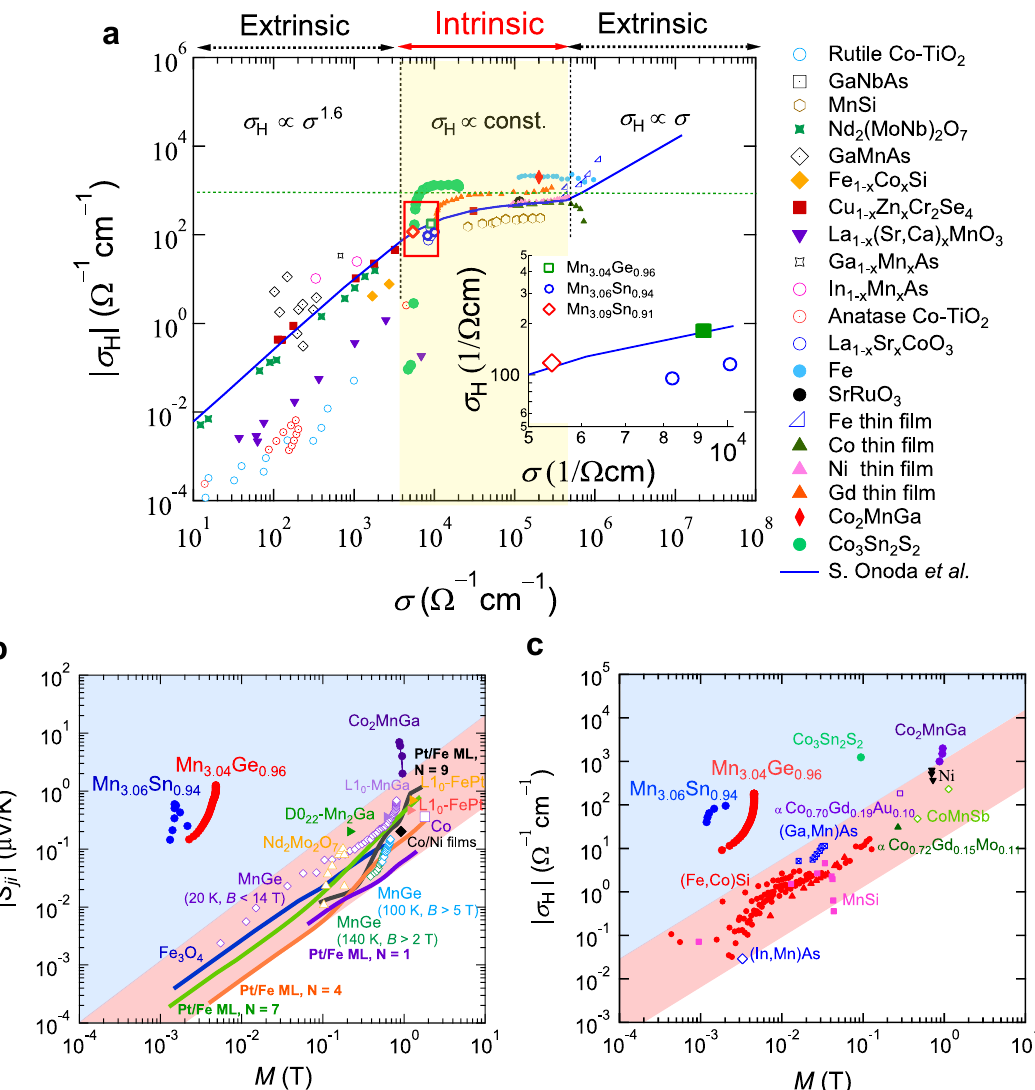
Fig. 6 Universal scaling relations for the magnetic Weyl semimetals. a Universal scaling relation between the Hall conductivity, σ H , and the longitudinal conductivity, σ , for Mn 3.04 Ge 0.96 (2 and 10K), Mn 3.06 Sn 0.94 (60 and 100K), and Mn 3.09 Sn 0.91 (100K) 4,9 , plotted together with the data for various ferromagnets including transition metals (Ni, Gd, Fe, and Co thin fi lms) 87 , Fe single crystals 87 , Co 3 Sn 2 S 2 31 , MnSi 89 , Fe 1- x Co x Si 89 , perovskite oxides (SrRuO 3 , La 1- x Sr x CoO 3 , La 1- x (SrCa) x MnO 3 ) 71 , spinels (Cu 1- x Zn x Cr 2 Se 4 ) 71 , pyrochlore (Nd 2 (MoNb) 2 O 7 ) 71 , and magnetic semiconductor (Ga 1- x Mn x As, In 1- x Mn x As, anatase – Co – TiO 2 , rutile – Co – TiO 2 ) 71 . Within the good metal regime of 3 ´ 10 3 (cid:3) σ (cid:3) 5 ´ 10 5 Ω (cid:2) 1 cm (cid:2) 1 (yellow shaded area), σ H is predominated by the intrinsic Berry phase contribution. The value of σ H lies below about 10 3 Ω − 1 cm − 1 (horizontal dotted line) and is nearly constant with σ . In the regime of σ (cid:4) 5 ´ 10 5 Ω (cid:2) 1 cm (cid:2) 1 , the extrinsic skew scattering contribution dominates σ H . The solid line presents the theoretical prediction by ref. 88 . Inset: zoomed plot showing the data for the Mn 3 Sn and Mn 3 Ge single crystals with different compositions, which corresponds to the region framed by the red rectangle in the main panel. b , c Full logarithmic plot of the magnetization ( M ) dependence of the Nernst coef fi cient j S ji j ( b ) and the Hall conductivity σ H ( c ) for Mn 3 Sn (blue), Mn 3 Ge (red), and other Weyl magnets 4,9,21,31 , in comparison with those for ordinary ferromagnets 9,26,71,87,96 . The red shades mark the regions in which j S ji j or σ H is linearly related to M for conventional ferromagnets. The Weyl magnets that violate this linear relation are located in the blue shaded σ σ (Fig. 6a, inset). Both features H value is nearly independent of indicate that Mn 3 X ( X = Sn, Ge) sits in the “ good metal ” regime,